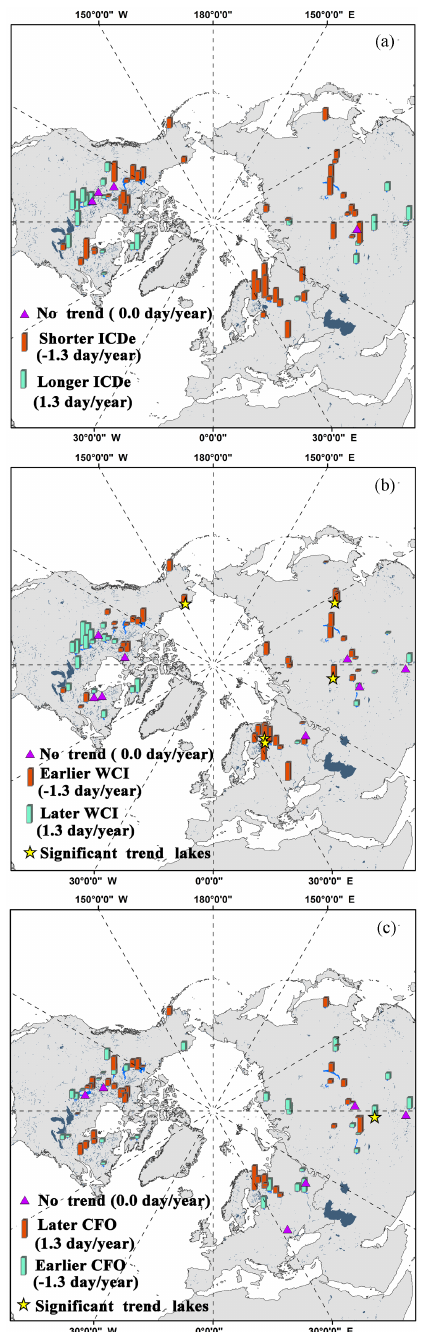
Figure 5. Changing trends of (a) ice cover duration (ICDe), (b) wa- ter clear of ice (WCI) dates, and (c) complete freeze over (CFO) dates of 71 lakes for the period 2002–2015. Lake changing trends are shown by bar symbols whose heights are proportional to the trend magnitudes; the significant trend lakes are marked by yellow stars, while purple triangles denote lakes where no trend was de- tected (rate of change is ∼ 0.0 dayyear − 1